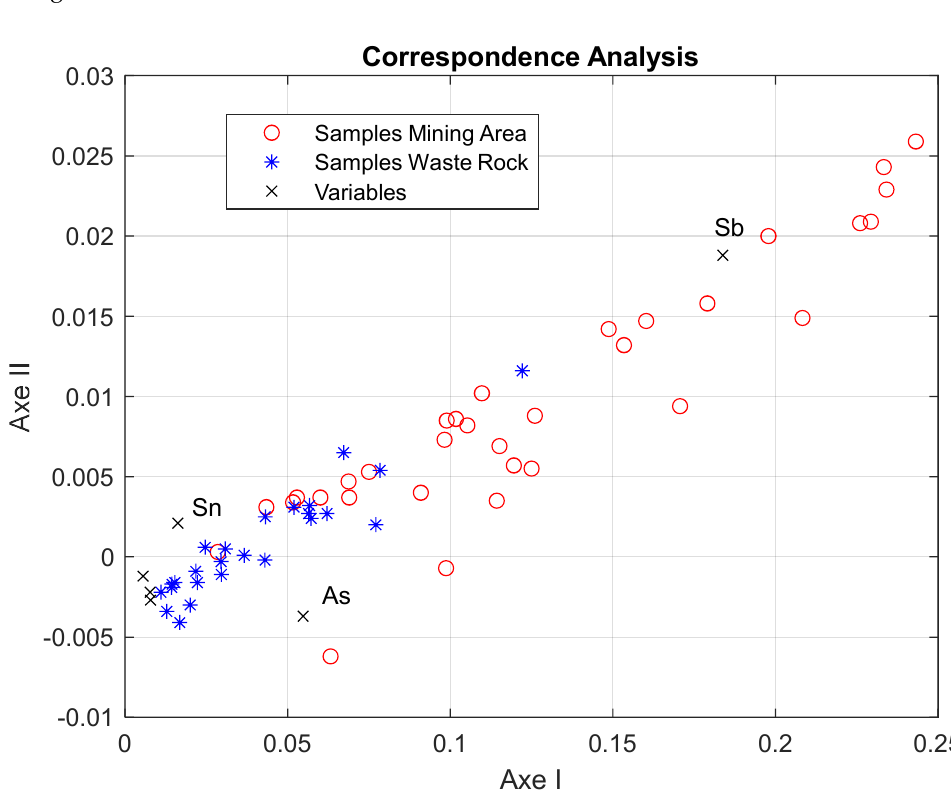
Table 3. Toxicological data for antimony and arsenic.